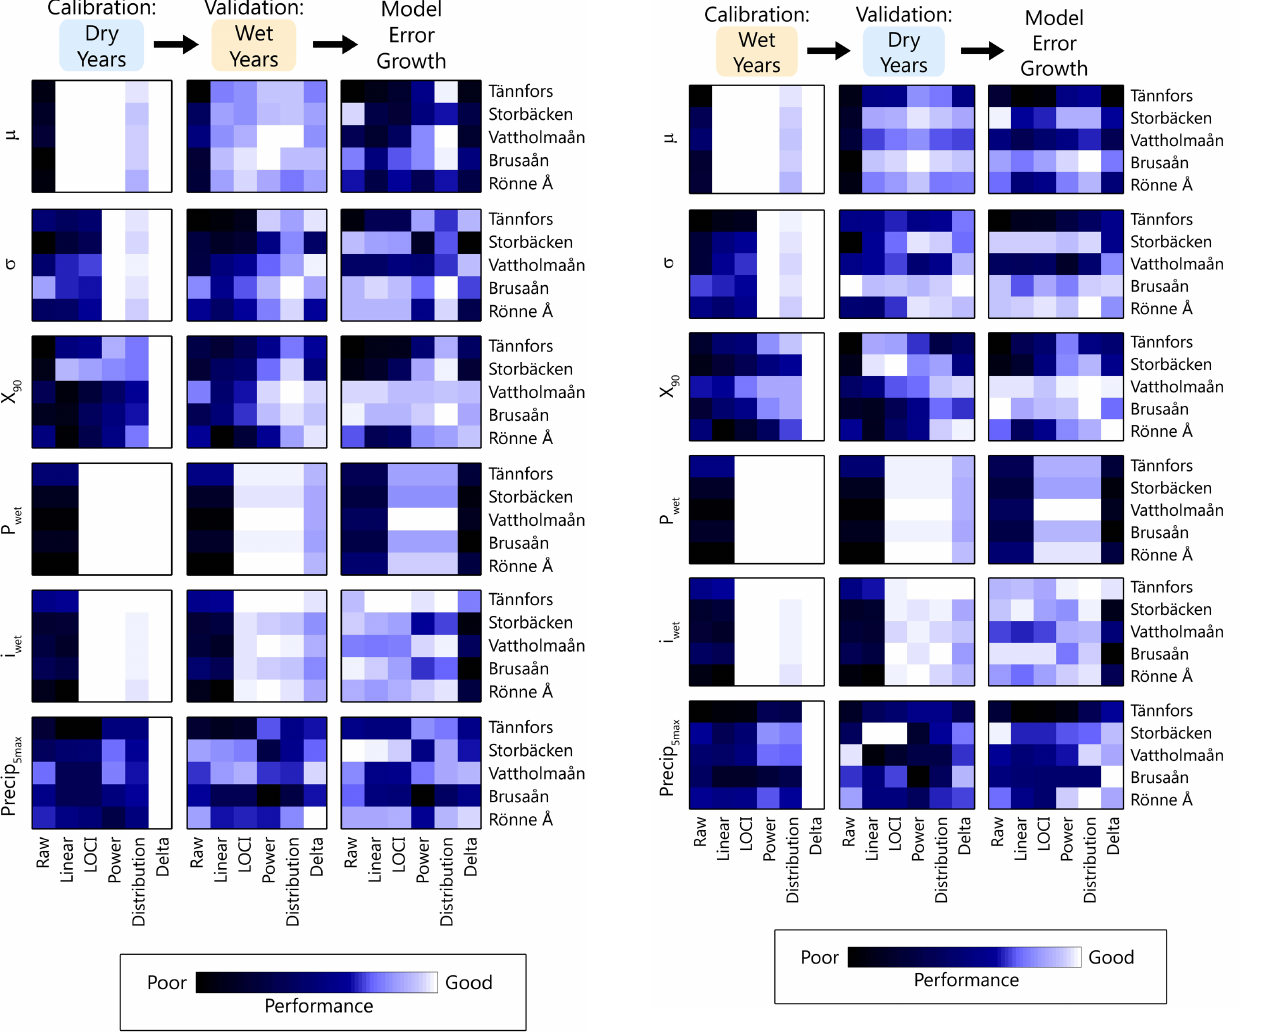
Fig. 5. Normalized precipitation model errors (different shades of blue) of 6 different statistical diagnostics (panel rows) for calibra- tion period (left panel column) and validation period (central panel column). The model error growth, i.e., the absolute difference be- tween model errors in validation and calibration period, is shown as well (right panel column). Each panel displays model error infor- mation depending on the 6 applied bias correction methods ( x axis) and the 5 catchment locations ( y axis). The figure is based on case-1 evaluation with calibration on dry years and validation on wet years.